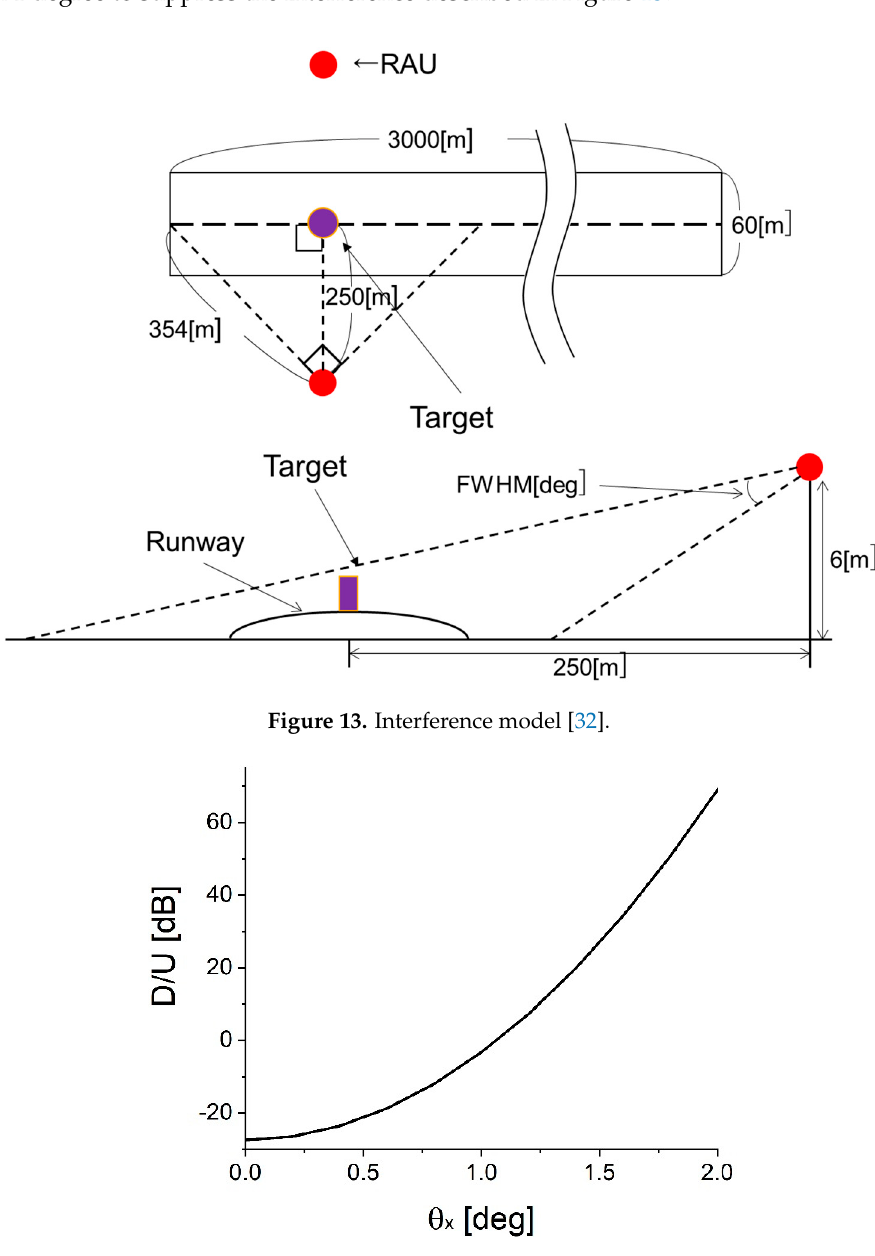
Figure 14. Desired and undesired signal (D/U) ratio. [32].